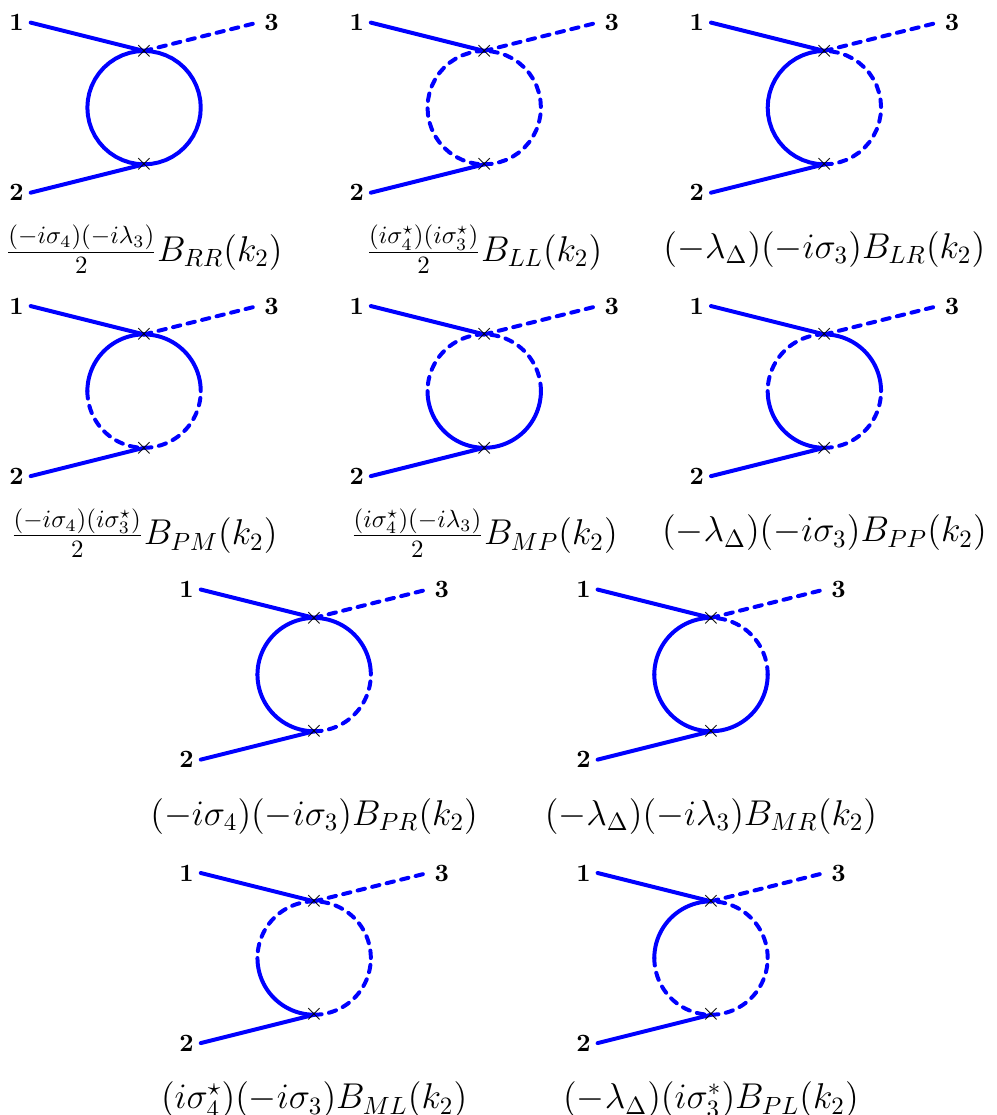
Figure 11. Diagrammatic representation of the Ten 1-Loop Integrals (cid:30) R (cid:30) R